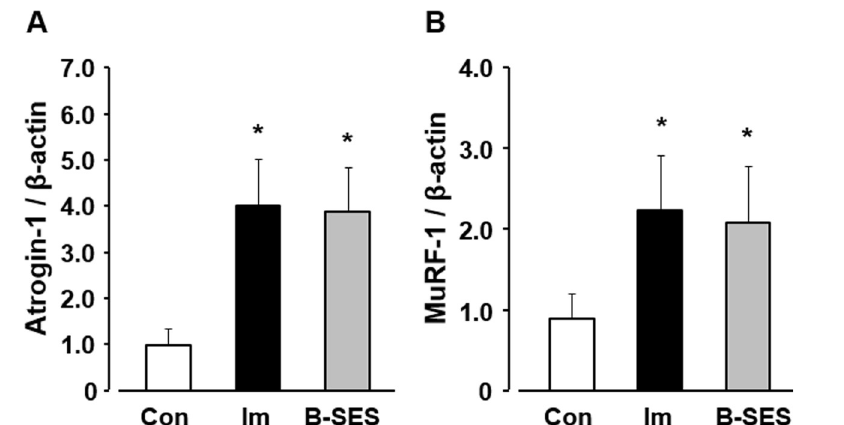
Fig 5. mRNA expression of Atrogin-1 (A) and MuRF-1 (B) in soleus muscles. Open bars represent the control group (Con). Black bars represent the immobilization group (Im). Gray bars represent the belt electrode-skeletal muscle electrical stimulation group (B-SES). Data presented as mean ± standard deviation. � , Significant difference (p < 0.05) compared with the control group.